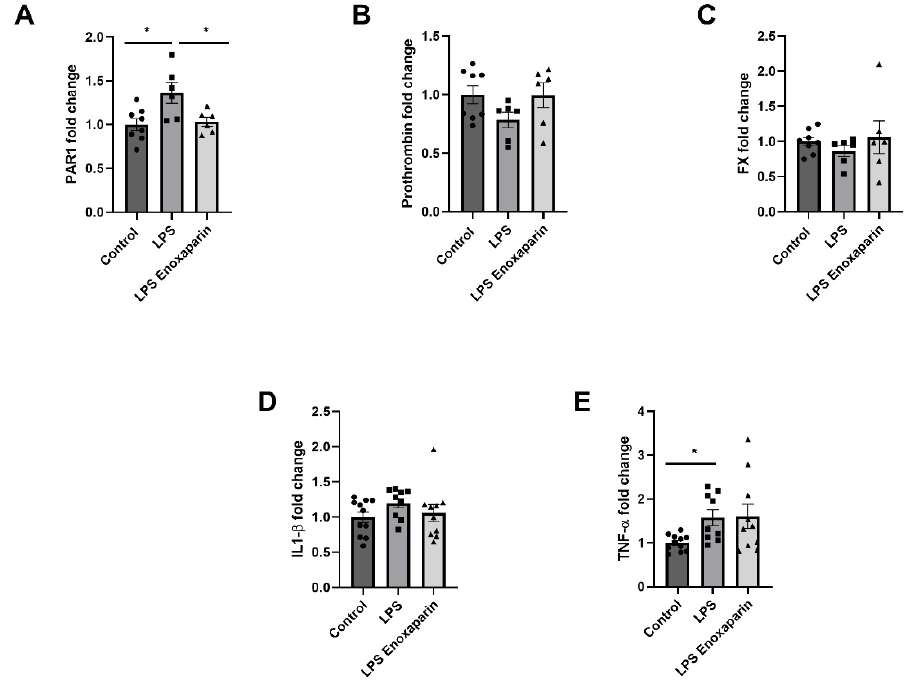
Figure 4. Coagulation and inflammation mRNA expression modification in the hippocampus of LPS animals one week after induction of neuro-inflammation: ( A ) PAR1 levels increased significantly in the LPS group compared to controls, with a significant reduction with enoxaparin treatment. No significant effect was measured in prothrombin ( B ) or FX ( C ) relative expression. Levels of inflam- matory markers IL1- β ( D ) and TNF- α ( E ) were elevated following LPS injection and insignificantly reduced with enoxaparin treatment (coagulation markers: control = 8, LPS = 6, LPS enoxaparin = 6. Inflammatory markers: control = 11, LPS = 9, LPS enoxaparin = 10). LPS—lipopolysaccharide, PAR1—protease-activated receptor, FX—factor X, IL1- β —interleukin 1 β , TNF- α —tumor necrosis factor α . * p < 0.05. Circles—control group; squares—LPS group; triangles—enoxaparin-treated LPS group.